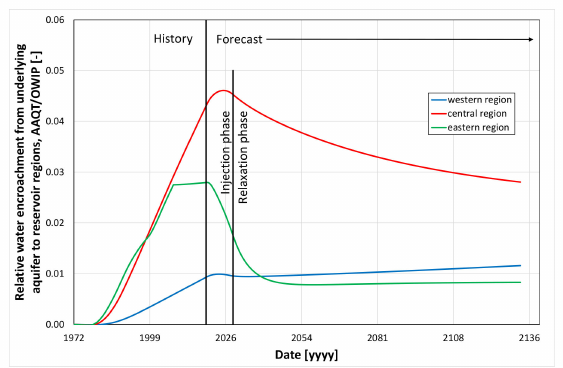
Figure 39. Relative water encroachment from underlying aquifer to reservoir